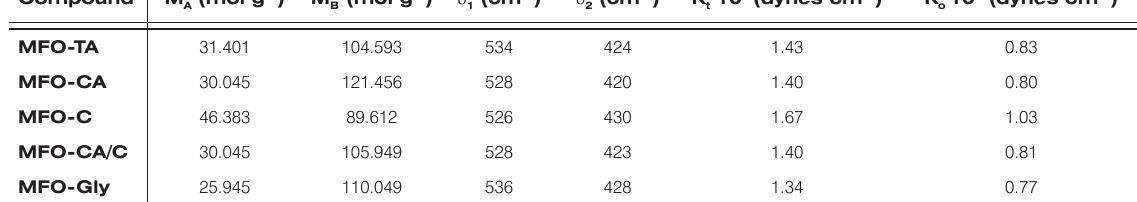
Table 2. Molecular weights ( M Compound